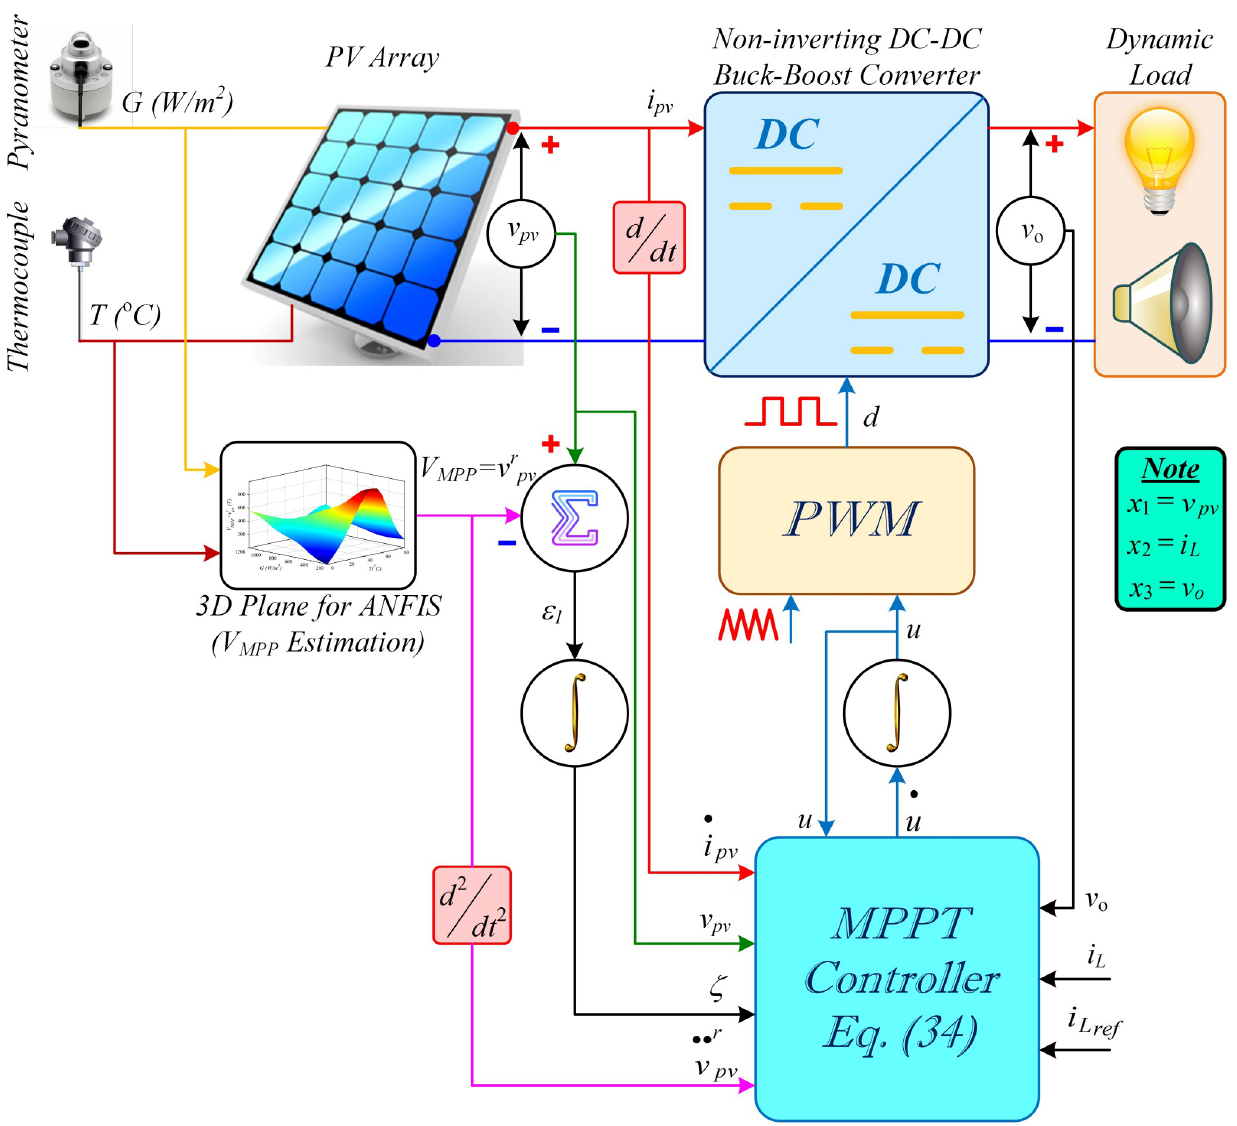
Fig 3. Block diagram of the overall proposed control